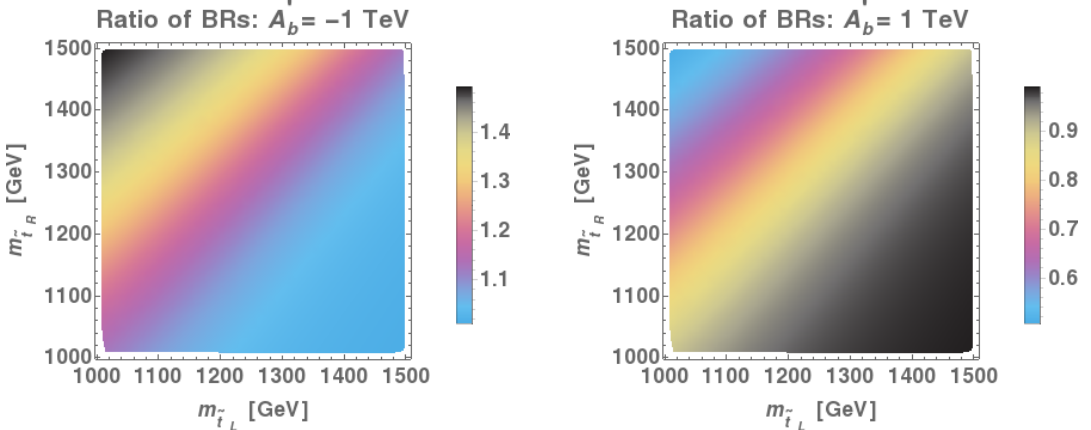
Figure 17 . Variations of the ratio of branching fractions for the decay ~ t 1 and the MSSM in the ~ t L -~ t R plane for A 0 values of tan (cid:12) (=40) and (cid:22) (=200 GeV). Other (cid:12)xed parameters are as in (cid:12)gure